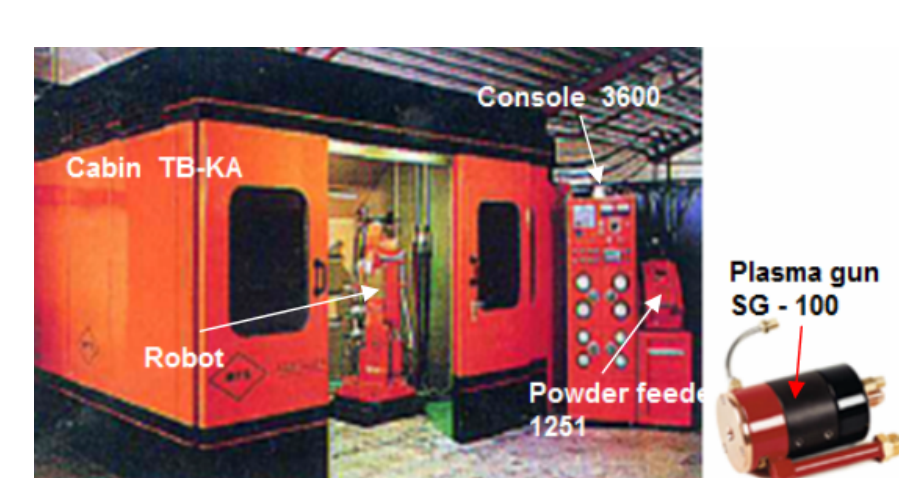
Figure 7 – APS equipment for plasma powder deposition at atmospheric